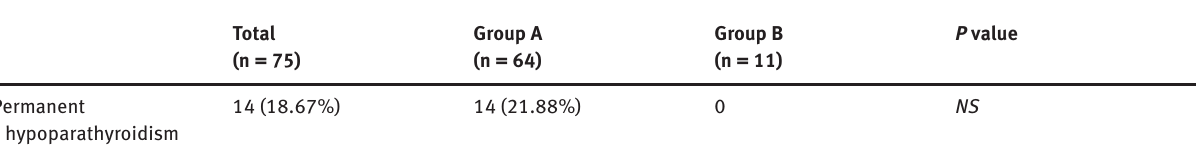
Table 2: Patients who developed permanent HPP.